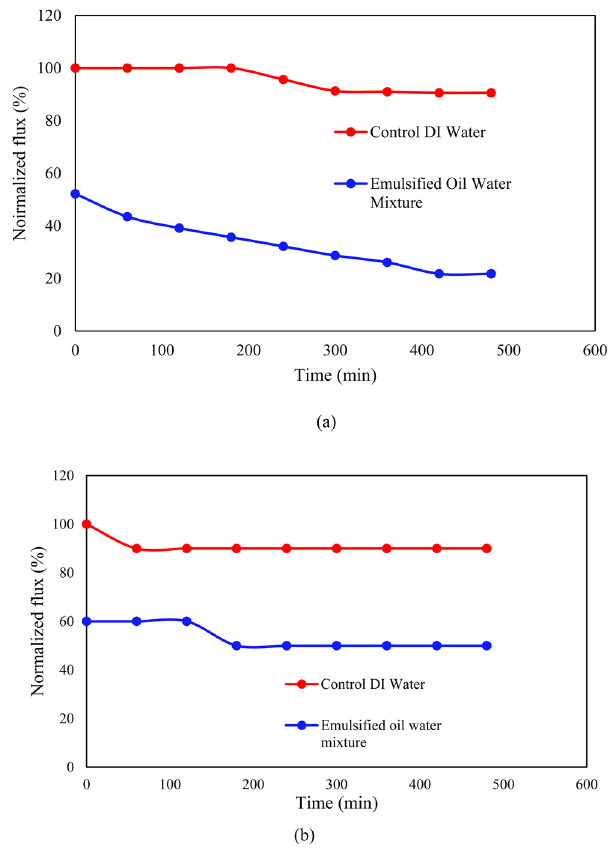
Figure 9. Comparison of the fouling behaviors of emulsified oil particles in the FO operations using ( a ) PES- TFC and ( b ) PES-TFC-g-PMAPS membranes under the AL-DS mode. Feed: DI water or 10,000 ppm oil water solution. Draw: 2 M NaCl